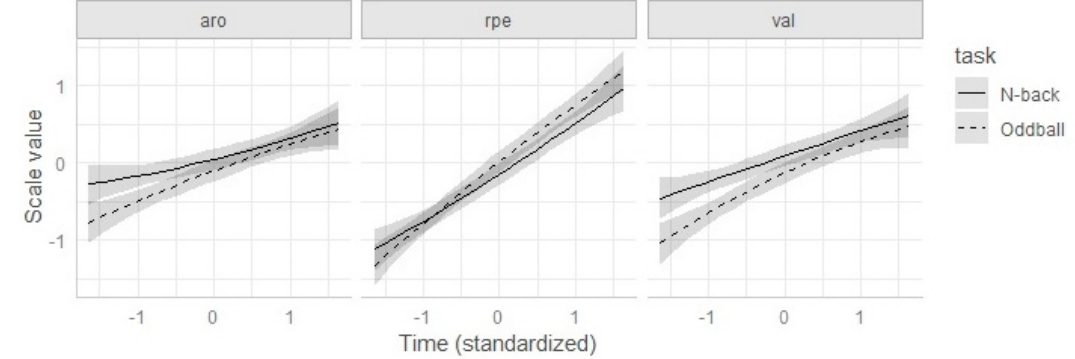
Figure 2. Predicted values from the best-fitting model for subjective scales: arousal (aro), valence (val), and RPE (rpe).